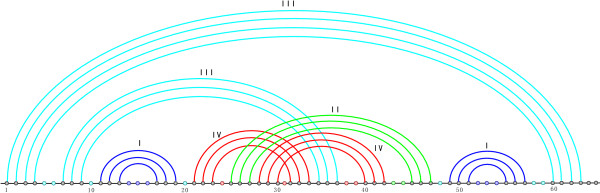
Loop decomposition. Here a hairpin-loop (I), an interior-loop (II), a multi-loop (III) and a pseudoknot (IV).